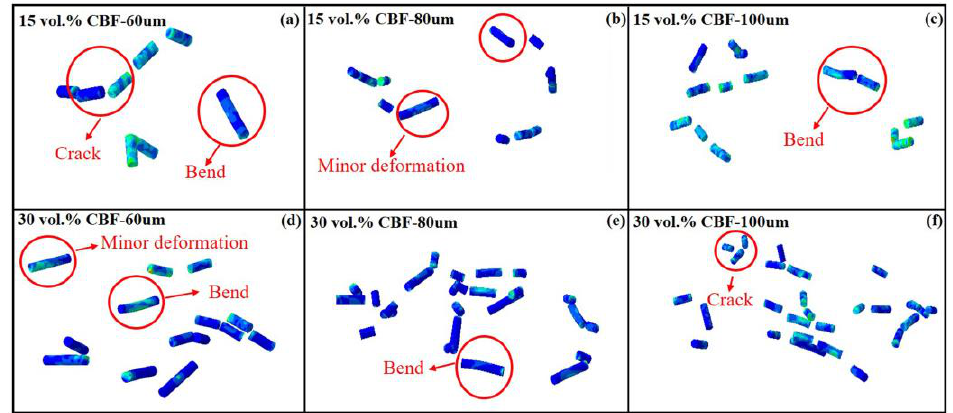
Figure 14. Basalt fibers in the mixed multi-particle simulated coating. The 15 vol.% CBF composite coating: ( a ) 60 μm ; ( b ) 80 μm ; ( c ) 100 μm . The 30 vol.% CBF composite coating: ( d ) 60 μm ; ( e ) 80 μm ;